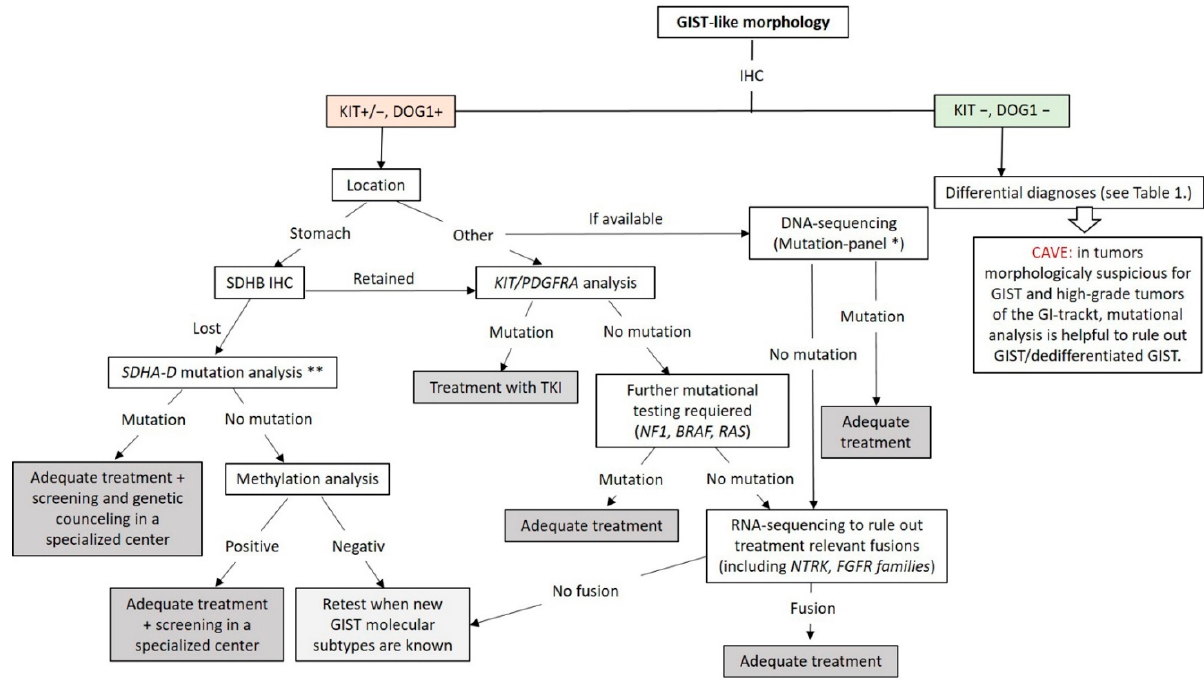
Figure 6. Diagnostic and molecular testing algorithm for GIST. * Our GIST mutation-panel includes following genes: PDGFA, KRAS, NRAS, HRAS, BRAF, KIT (Exon 8,9,10,11,12,13,17,18), PDGFRB (Exon 12,13,14,17,18), TP53 (Exons 4–10), SDHA, SDHB, SDHC, SDHD, NF1, CDKN2A and RB1. ** If available, mutation-panel is performed. TKI: Tyrosin Kinase Inhibitor.